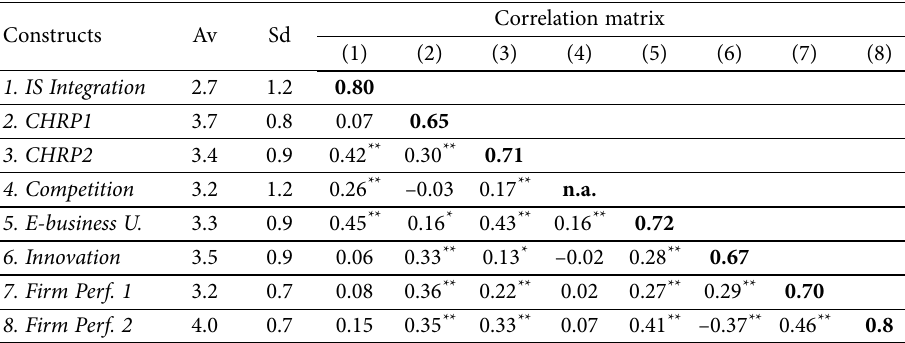
Table 1. Descriptives statisticts and discriminant